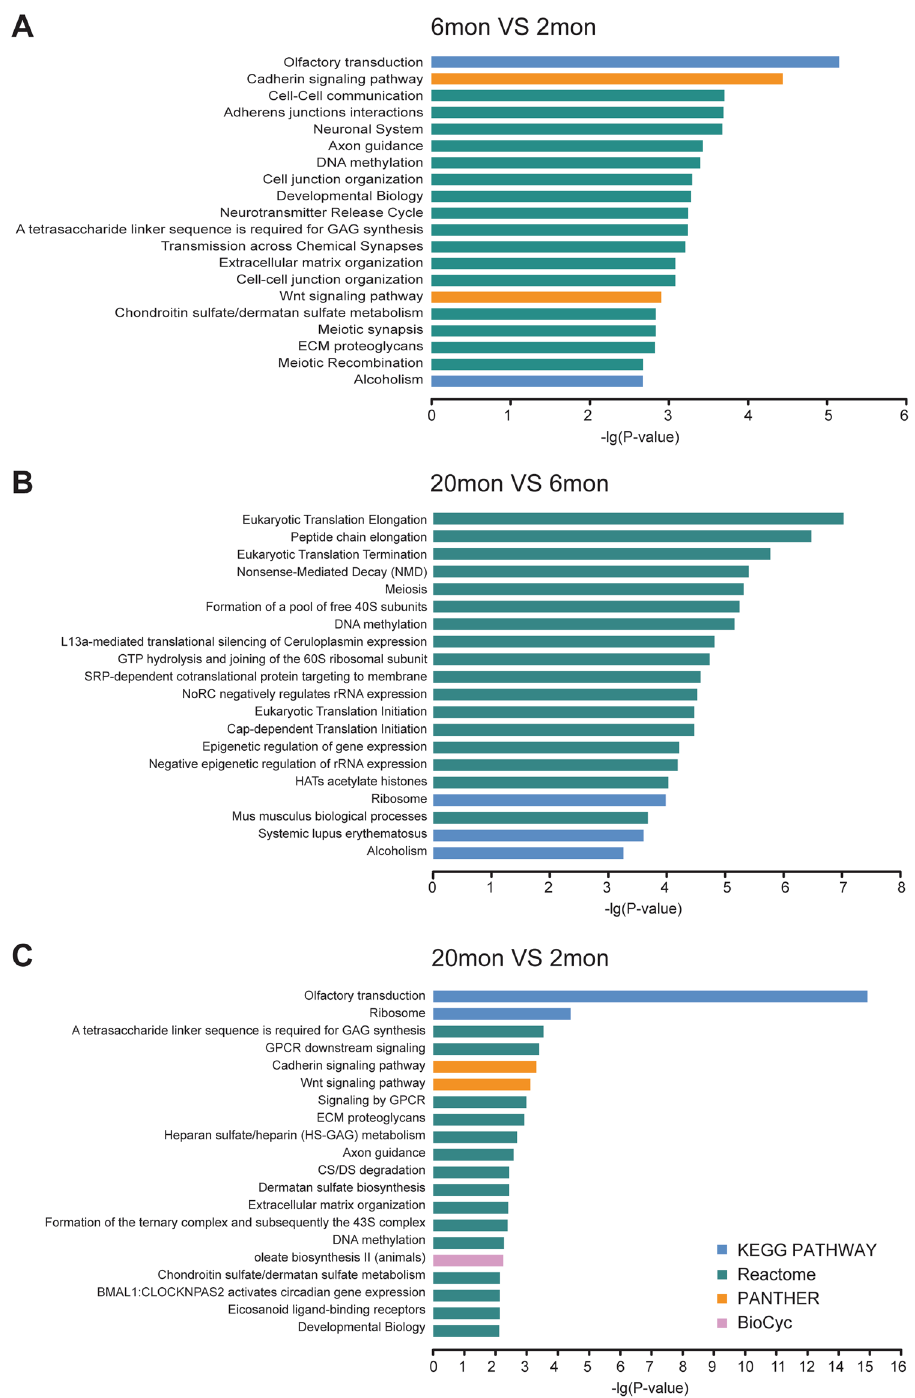
Figure 4. Pathway analysis of altered PCGs. Altered PCGs of mature versus young adult mice ( A ), aged versus mature mice ( B ), and aged versus young adult mice ( C ) were loaded into KOBAS 2.0 for assessment of enriched pathways. The top 20 significantly enriched pathways from pathway databases KEGG PATHWAY, BioCyc, Reactome and Panther were calculated when plotted as the − lg( p -values). Total significantly enriched pathways are shown in detail in Supplementary File